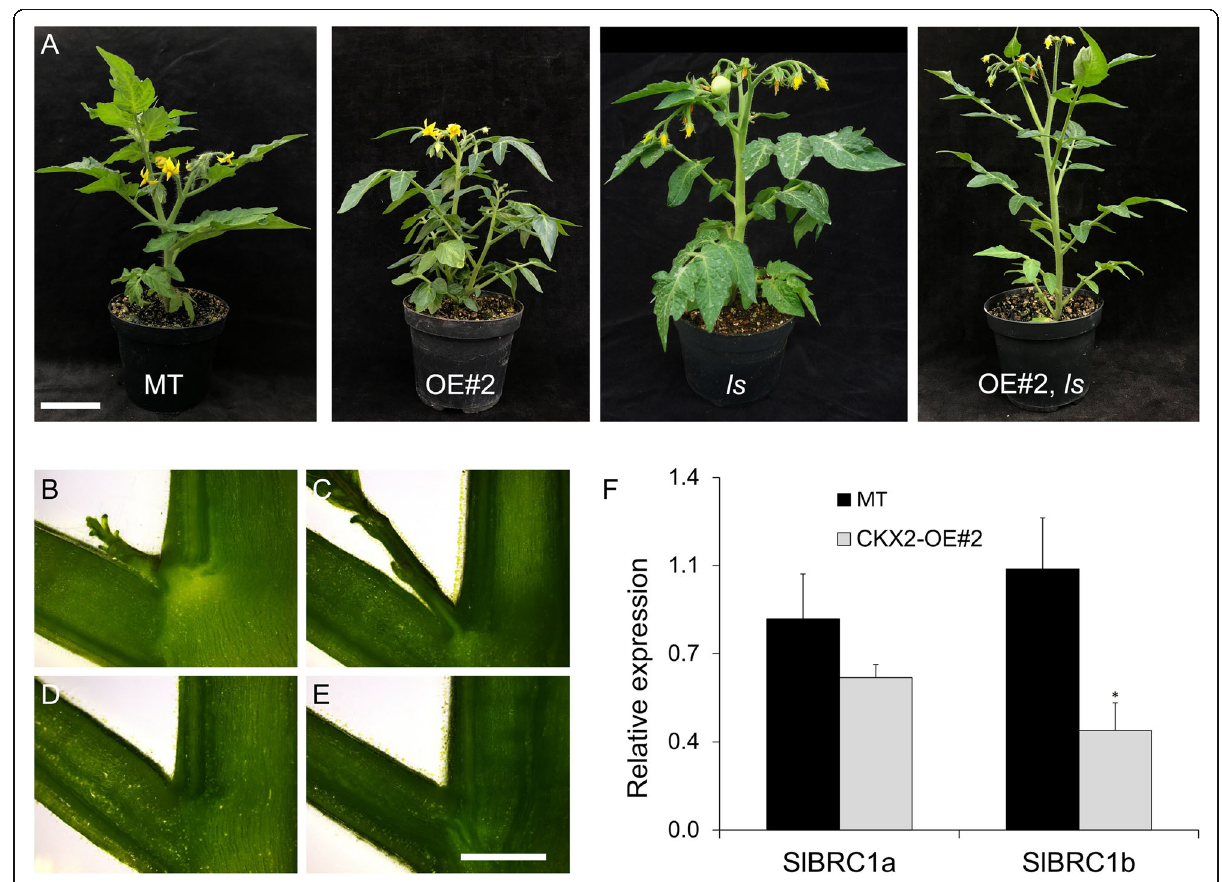
Fig. 3 Shoot branching in CKX2-overexpressing plants is dependent on functional LS and linked to BRC1 repression. A. Representative phenotype of plants of MT, CKX2-OE#2, ls mutant and the double transgenic-mutant CKX2-OE, ls . B to E . Longitudinal shoot section of MT ( B ), CKX2-OE#2 (C), ls ( D ) and CKX2-OE, ls ( E ) leaf axil; bar = 2 mm. F . Expression levels of SlBRC1a and SlBRC1b in axillary buds (0.5 to 1.0 cm) harvested from the 3rd and 4th nodes of vegetative plants of MT and CKX2-OE#2. Data are means ± SE of three biological samples. Statistical comparisons shown were made between the MT and transgenic line (Student ’ s t -test; P <